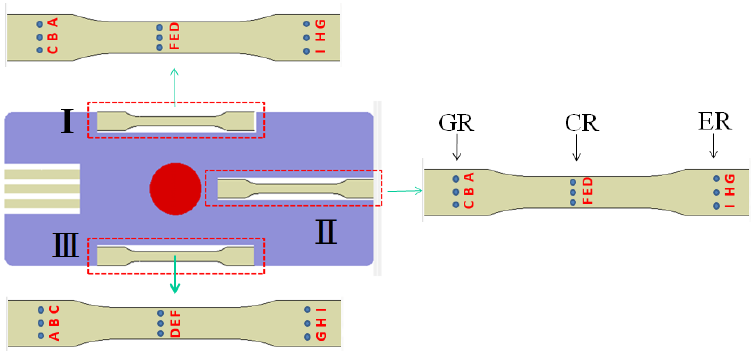
Figure 3. The moldbase and cooling channel layout.